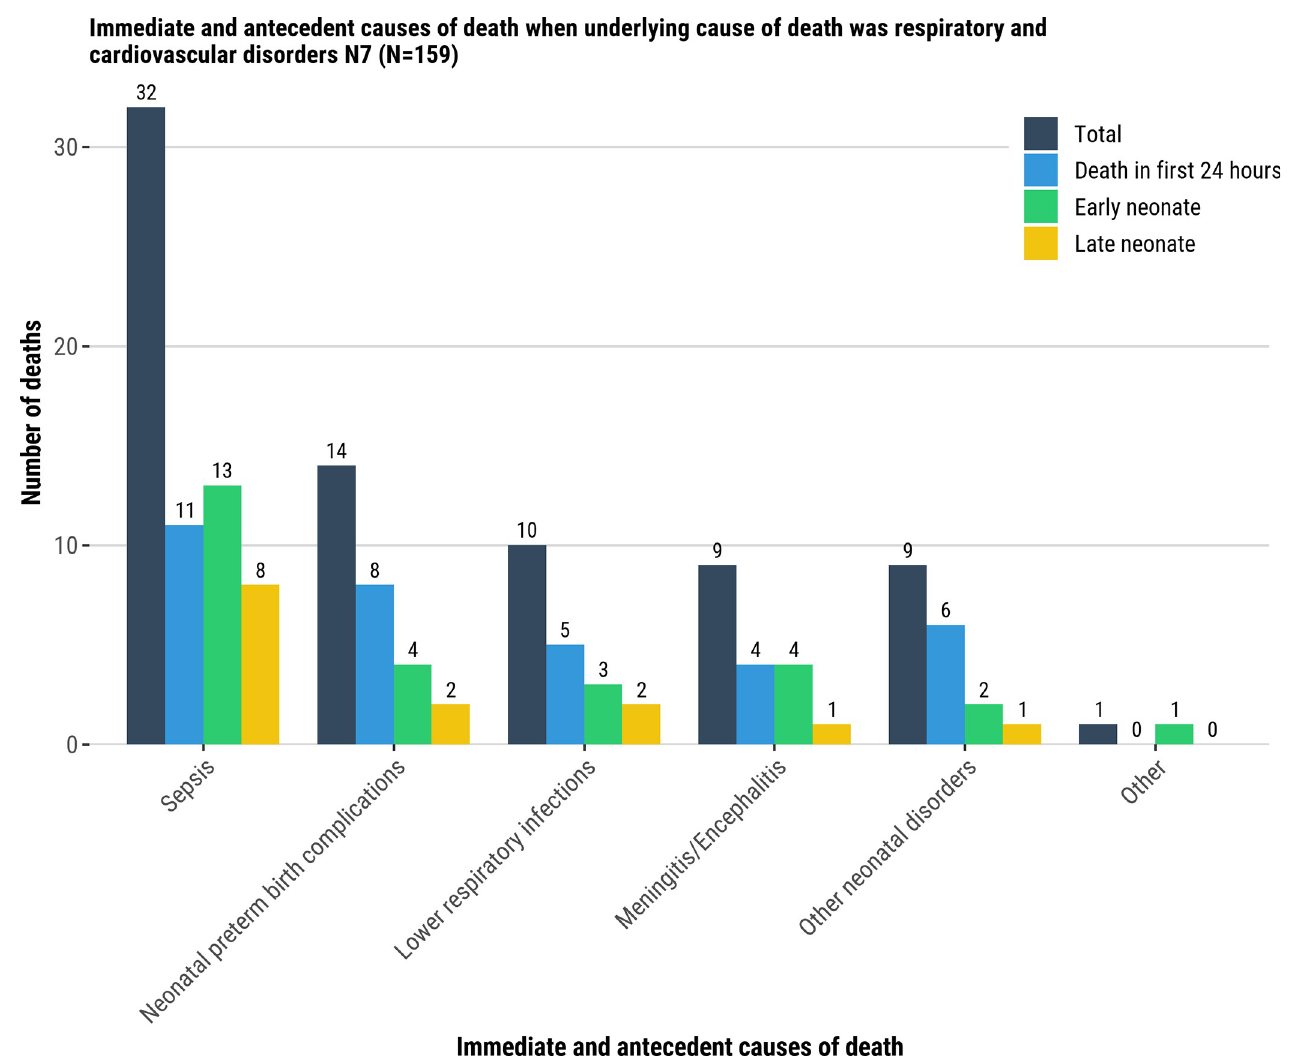
Fig 6. Immediate and antecedent causes of death when underlying cause of death was respiratory and cardiovascular disorders N7 (N = 159). Immediate and antecedent causes of death.